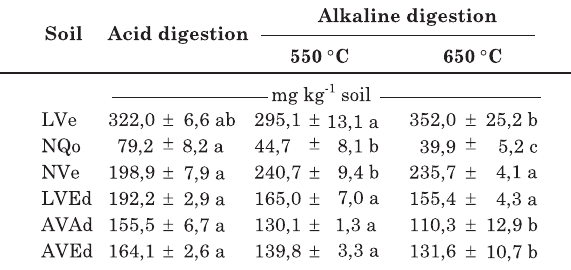
Table 8. Total S by acid and alkaline digestion using an oxidation mixture of NaHCO